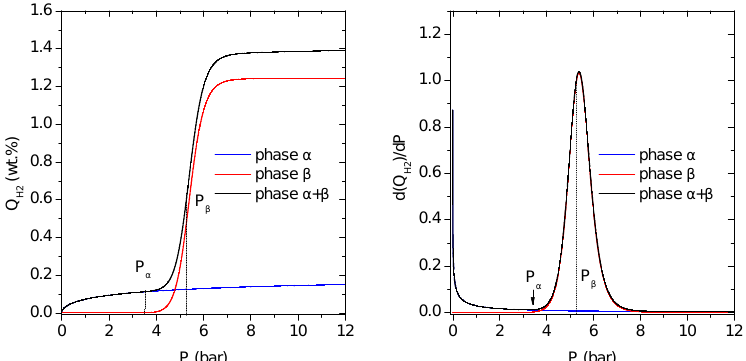
Figure 3. Evolution of the amount of absorbed hydrogen by two phases α and β as a function of increasing pressure P at T = 323 K. The computational results for the α and β phases were obtained for the first N 1 ( P ) and second components N 2 ( P ) using equation (Equation (13)). The average hydrogen amount N a as a function of pressure is given by equation (Equation